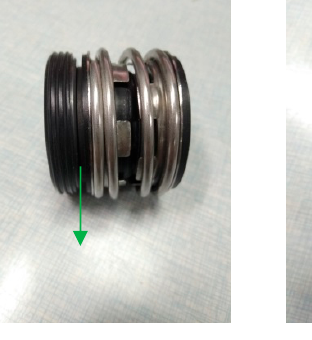
Figure 2. Physical pictures of different fault degrees.